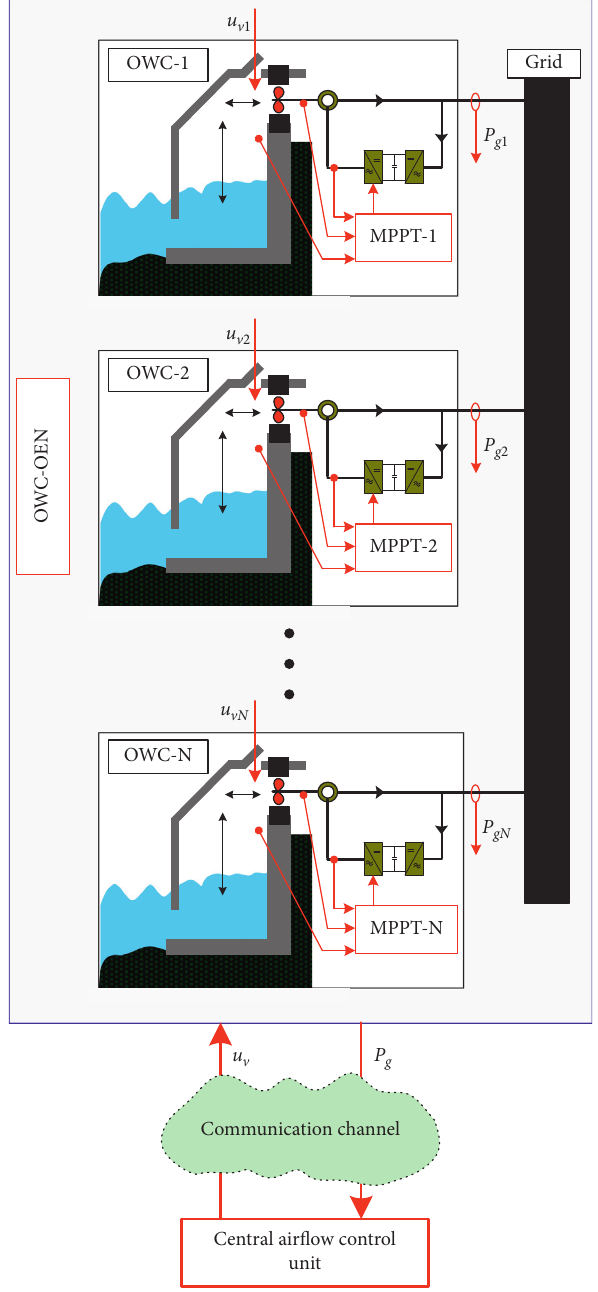
Figure 5: Block diagram of OWC-OEN and its centralized control